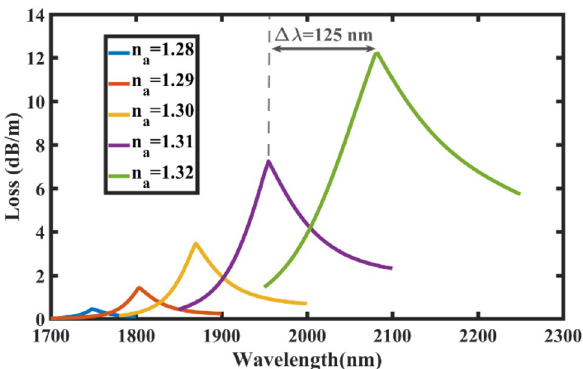
Figure 8. Loss spectra of the proposed SPR sensor simulated at different analyte RIs. The gold thickness is t g = 60 nm and distance to the air holes is t h = 200